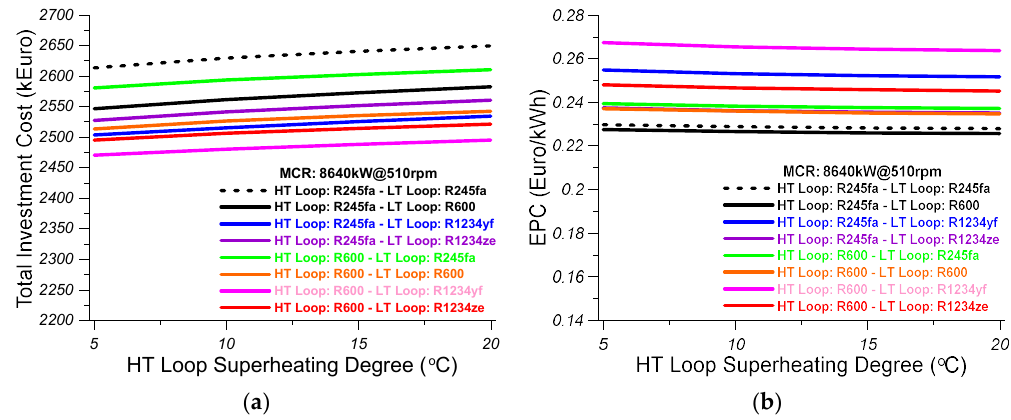
Figure 10. (a) Effect of the superheating degree of the organic medium in the HT loop on the total investment cost of the regenerative dual-loop ORC; (b) Effect of the superheating degree of the organic medium in the HT loop on the electricity production cost (EPC) of the regenerative dual-loop ORC. Results are given for all the pairs of organic mediums that are examined in the present study.